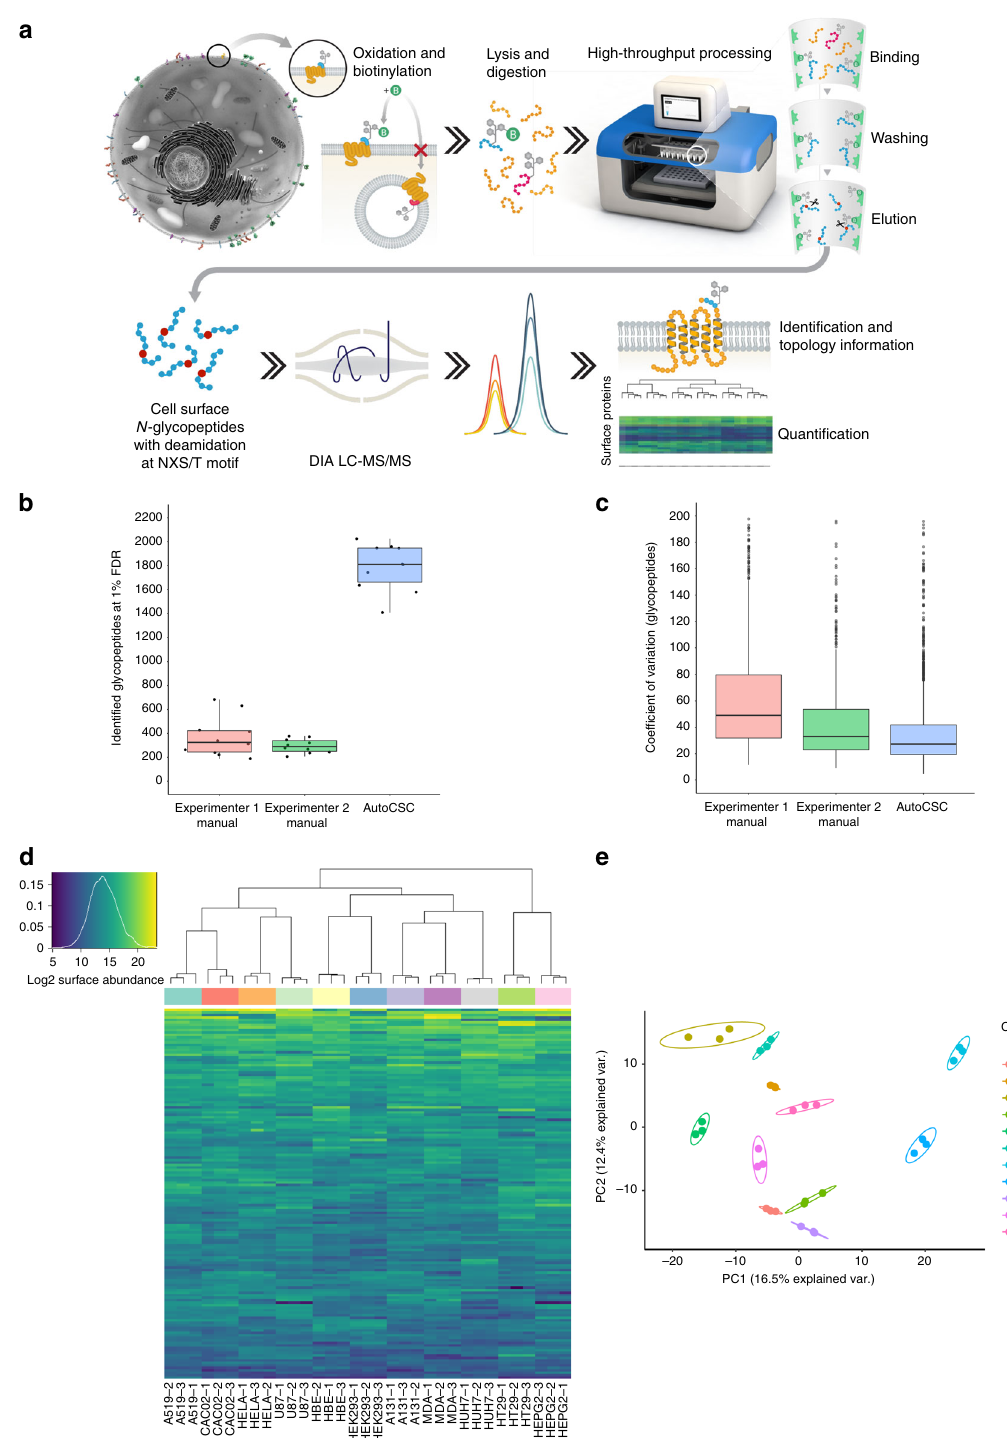
Fig. 1 autoCSC enables quantitative surfaceome analysis with higher sensitivity, reproducibility, and throughput than the manual process. a Schematic illustration of the autoCSC work fl ow. b Box-plots showing identi fi ed N -glycopeptides and c quanti fi cation CVs (of precursors matching glycopeptides) of manual and automated (autoCSC) processing work fl ows. d Heatmap representation and e principal component analysis of quanti fi ed surfaceomes in 11 common cell lines. The center line of box-plots represents the median, box limits the upper and lower quartiles, whiskers the 1.5x interquartile range and dots any outlier data